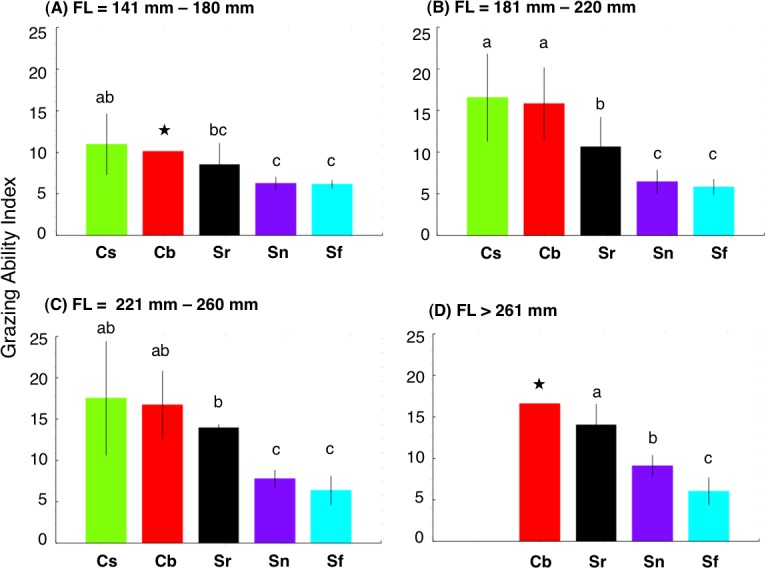
Interspecific difference in grazing ability index (GAI) for four fork length (FL) ranges.The different alphabet characters on the bars indicate the significant difference in GAI (Games-Howell test, p < 0.05). Vertical lines represent standard deviation. Star symbols in (A) and (D): only 1 individual for Chlorurus bowersi and excluded from Games-Howell test due to no standard deviations. No individuals for C. sordidus in (d). Species names are abbreviated as Cs, Chlorurus sordidus; Cb, C. bowersi; Sr, Scarus rivulatus; Sn, S. niger; Sf, S. forsteni.